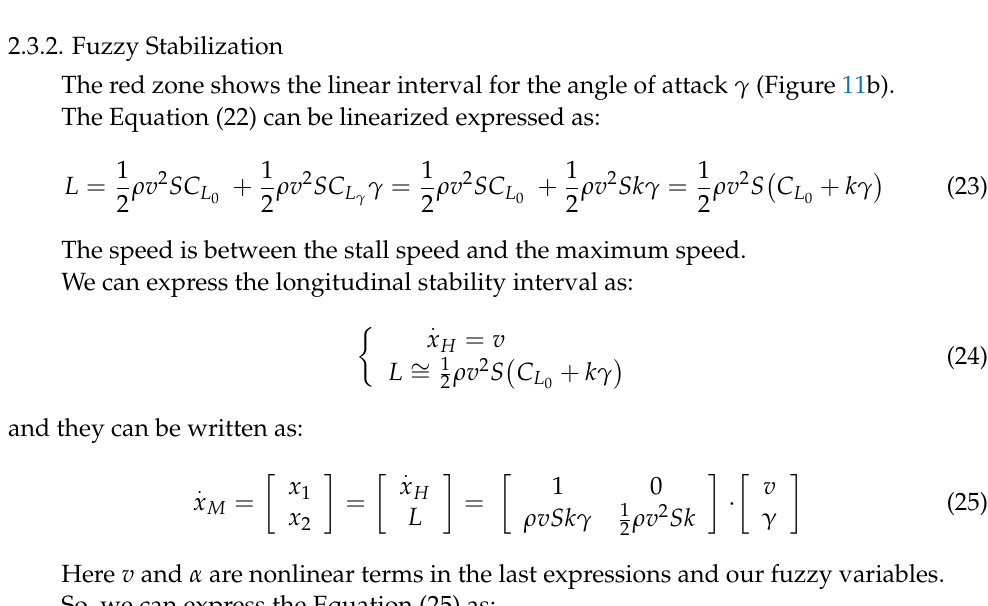
Figure 11. The whole drone hydrodynamic behavior ( a ) coefficient of lift vs. coefficient of drag; ( b ) coefficient of lift vs. angle of attack: the zone evidenced in red is linear.